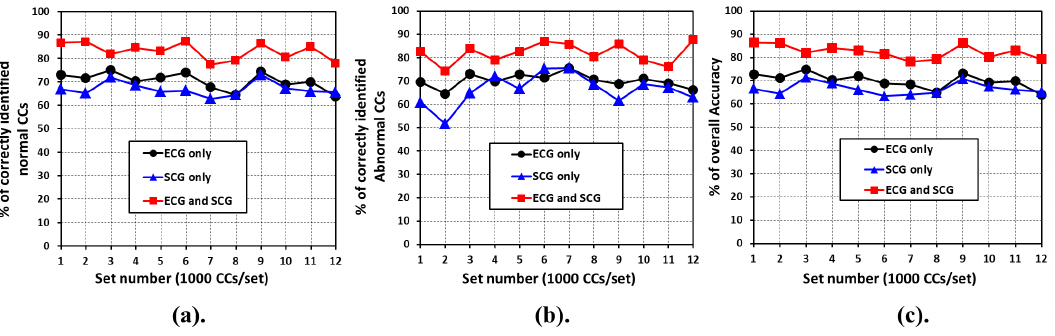
Figure 11. Performance comparison of ECG only, SCG only, and ECG and SCG combined